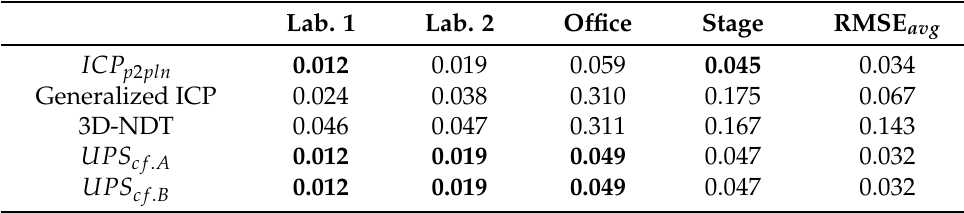
Table 10. RMSE (in meters) of registration of pairs of indoor scenes.